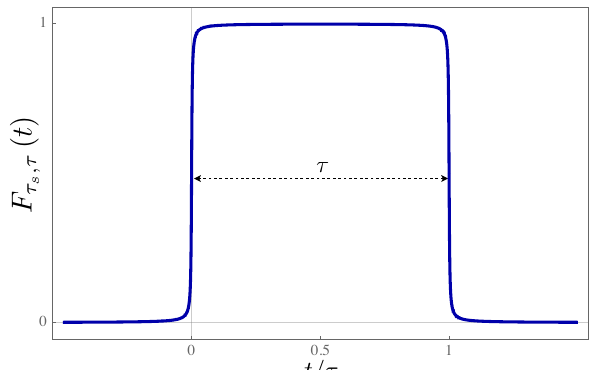
(cid:28) s ;(cid:28) ( t ) de(cid:12)ned by eq. (2.2), with a switching